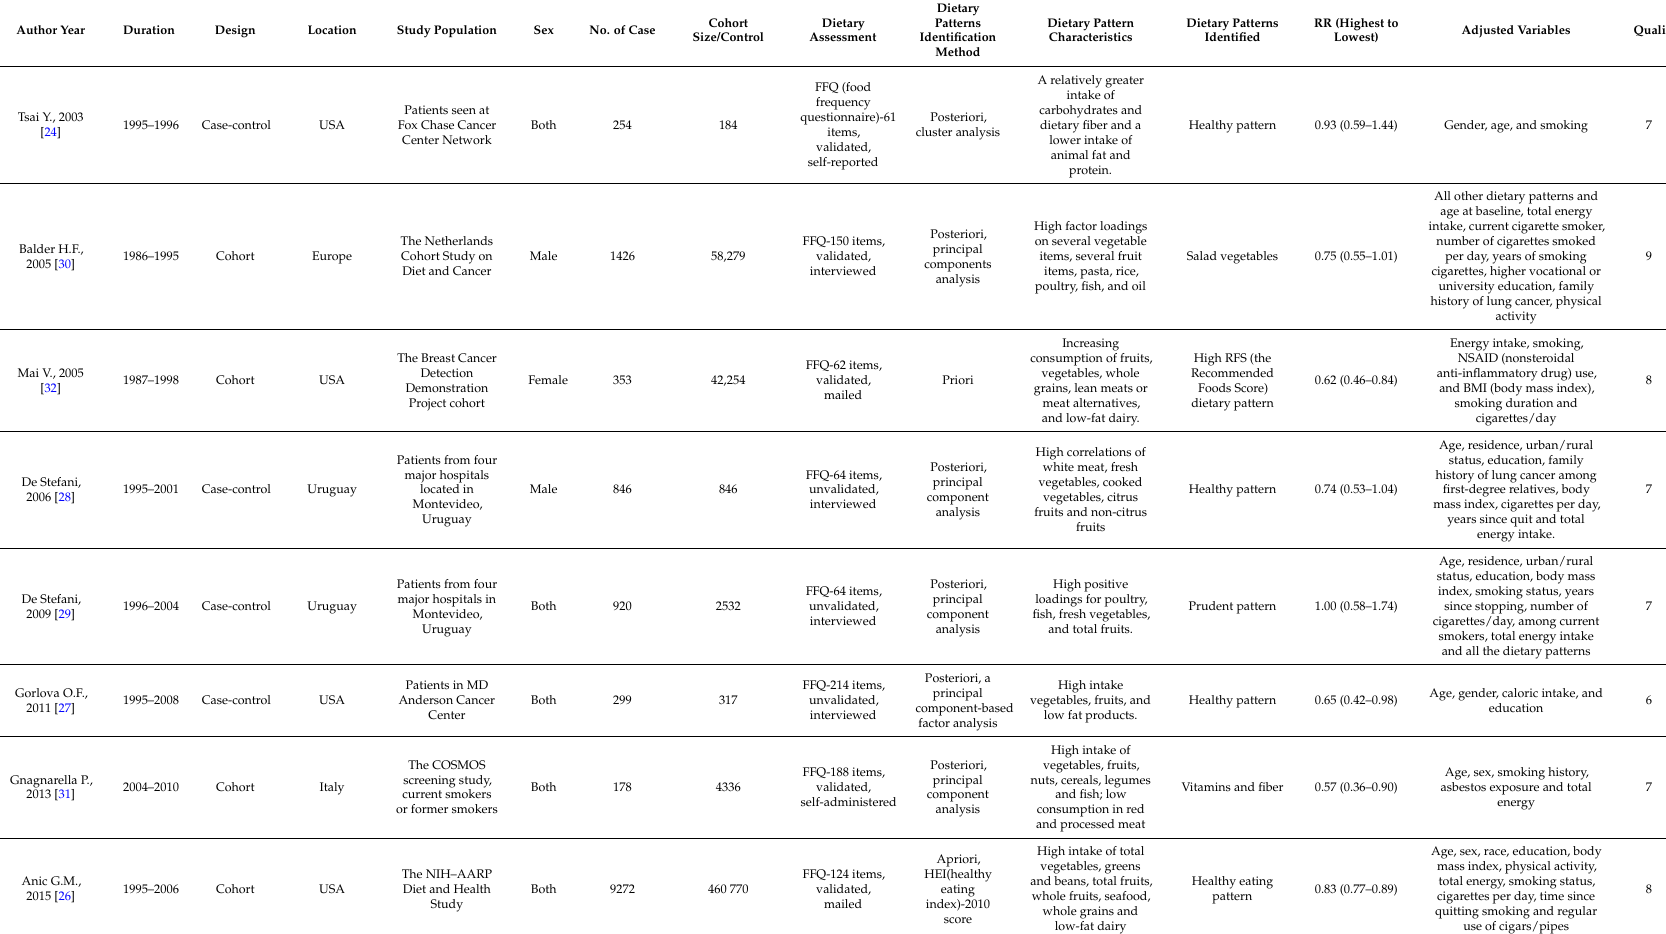
Table 1. Characteristics of studies included in the meta-analysis on the association between healthy dietary pattern and lung cancer